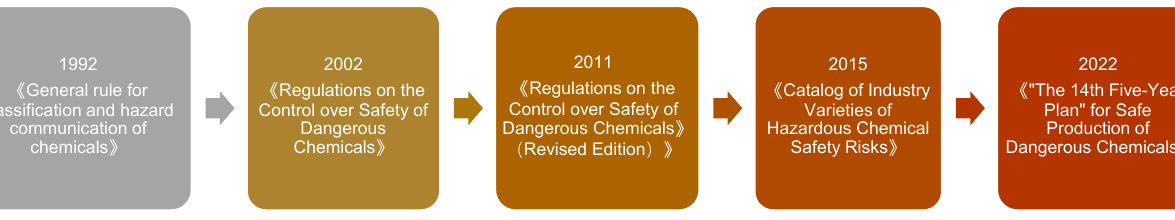
Figure 11. China’s hazardous chemical industry safety standards construction history.